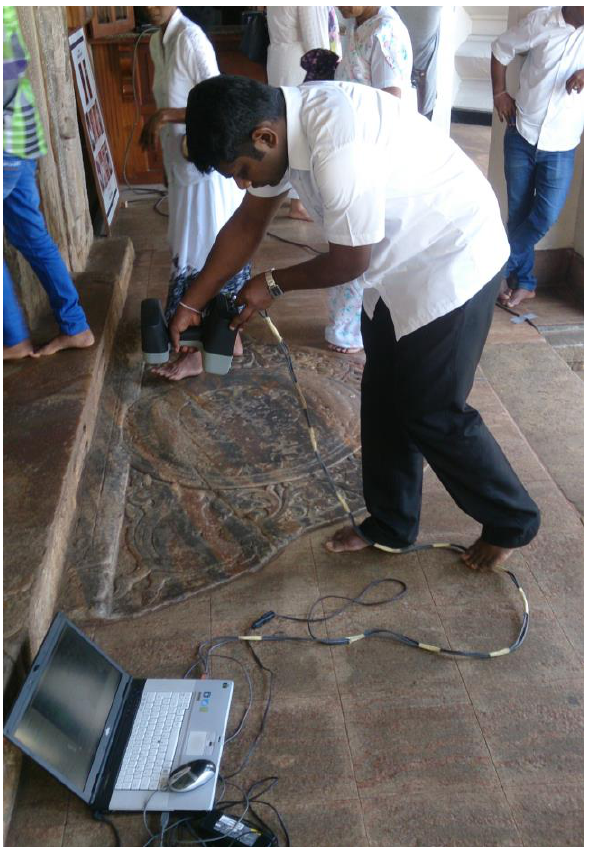
Fig. 5. Documentation of the moonstone at the entrance to the inner temple with Artec